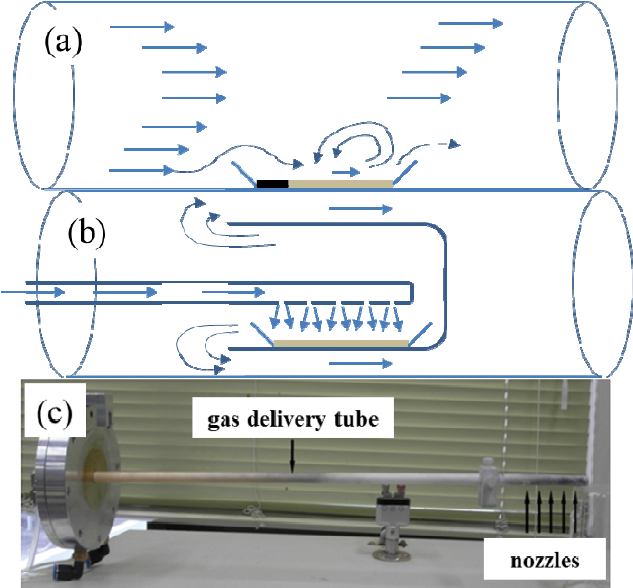
Figure 1. Gas flow schemes for: ( a ) a conventional flow-through reactor; ( b ) a nozzle-type reactor; and ( c ) the actual photo of the nozzle